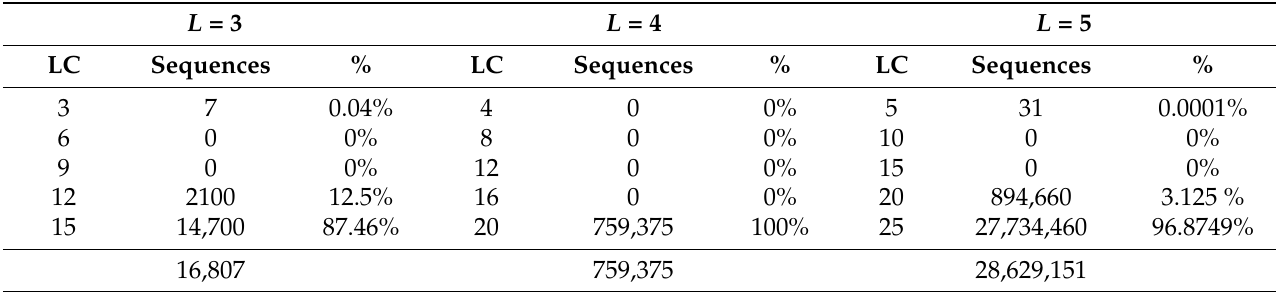
Table A3. Number and percentage of 5-interleaving sequences, with different values of LC , formed by PN-sequences with characteristic polynomials of degree L =